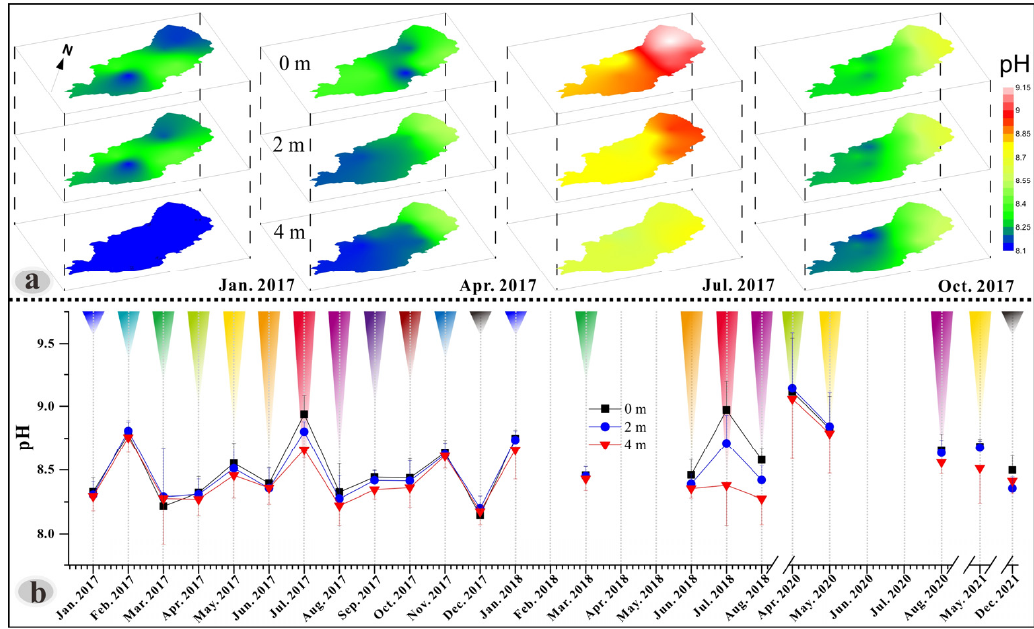
Figure 5. Seasonal and annual pH variations in Lake QL. ( a ) Temporal and spatial variation characteristics in pH; ( b ) Interannual variations in pH .